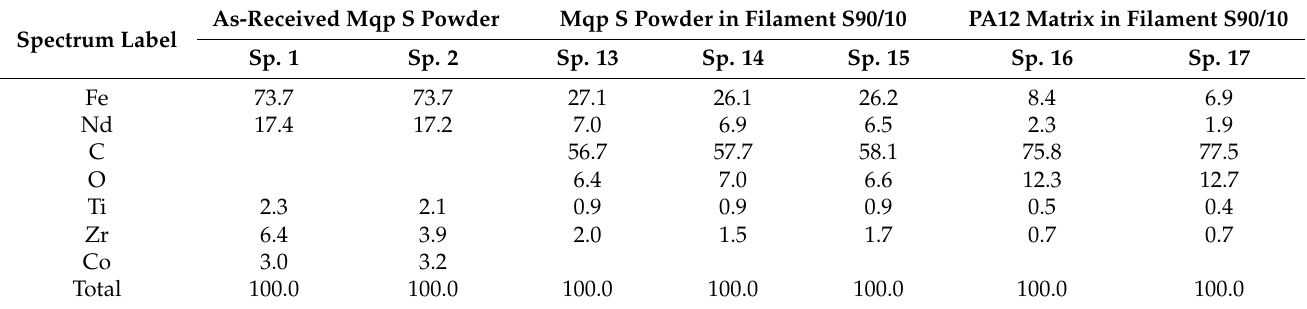
Table 5. Elemental composition (wt.%) of the as-received Mqp S powder and filament S90/10.